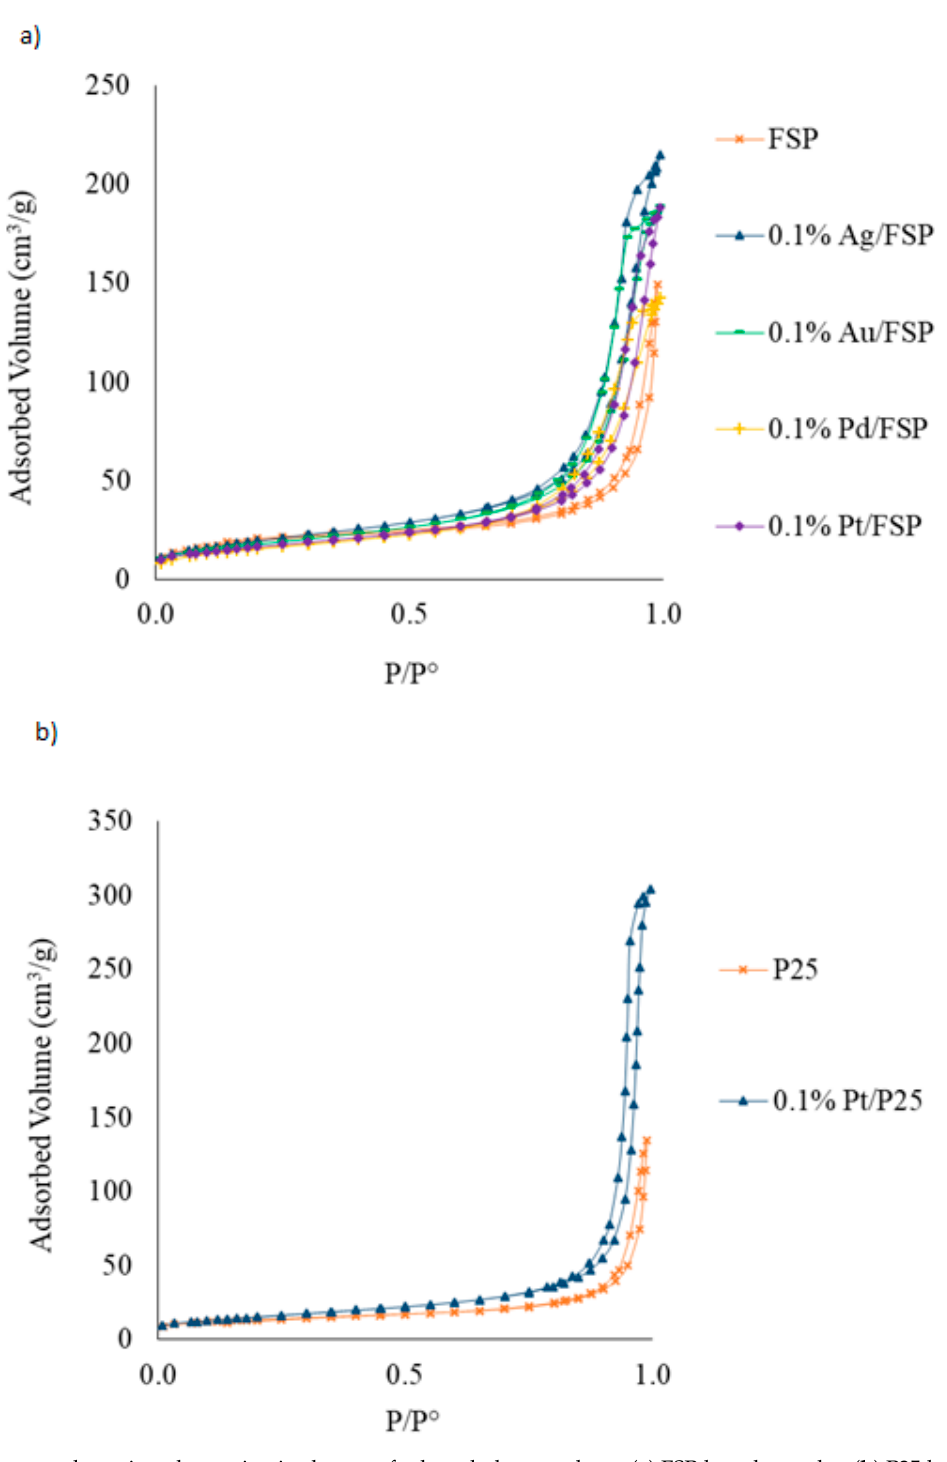
Figure 1. Nitrogen adsorption–desorption isotherms of selected photocatalysts: ( a ) FSP-based samples; ( b ) P25-based sam- ples.